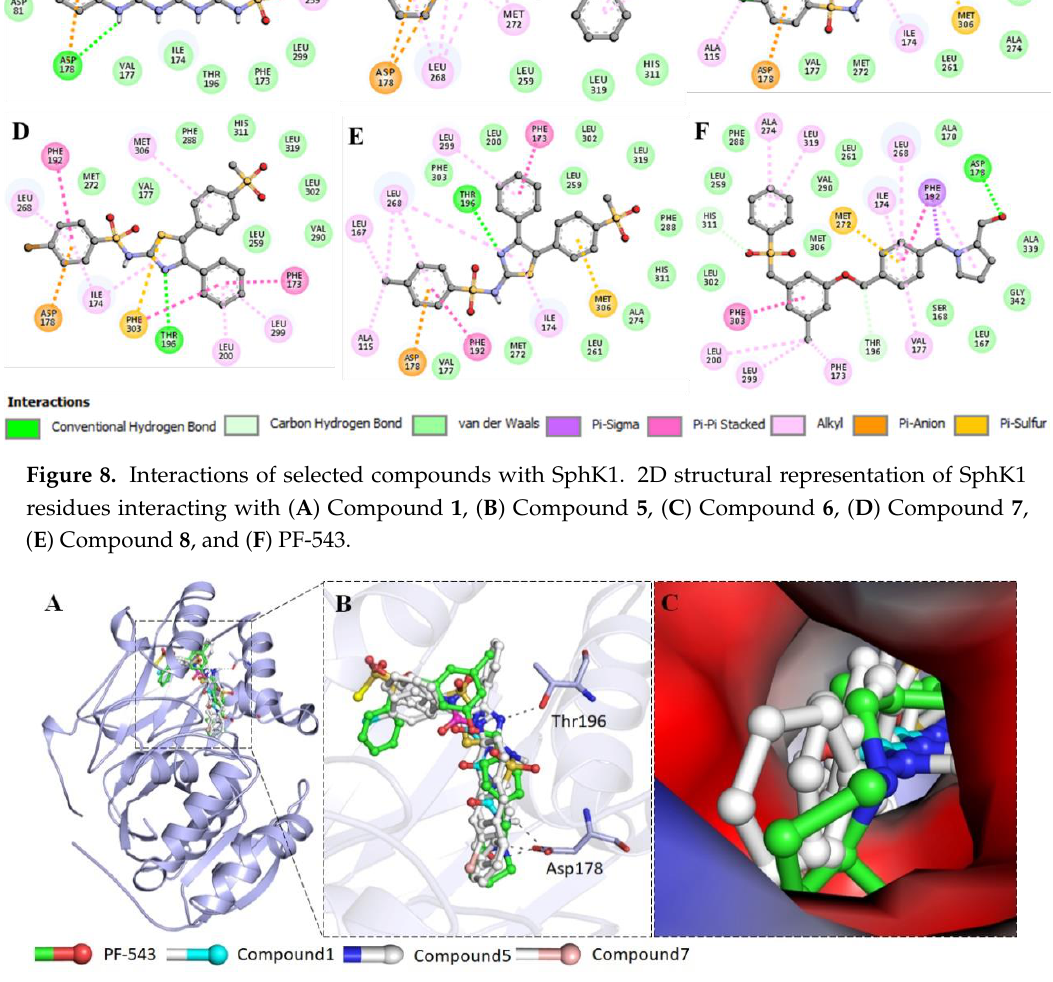
Figure 9. Structural representation of the binding pattern of Compounds 1 , 5 , and 7 along with PF-543 in the substrate-binding site cavity of SphK1. ( A ) Cartoon representation of SphK1 showing ligands bound to the active site cavity. ( B ) Interaction of Compounds 1 , 5 , and 7 to the SphK1 residues. ( C ) Surface model highlighting the active site pocket of SphK1.